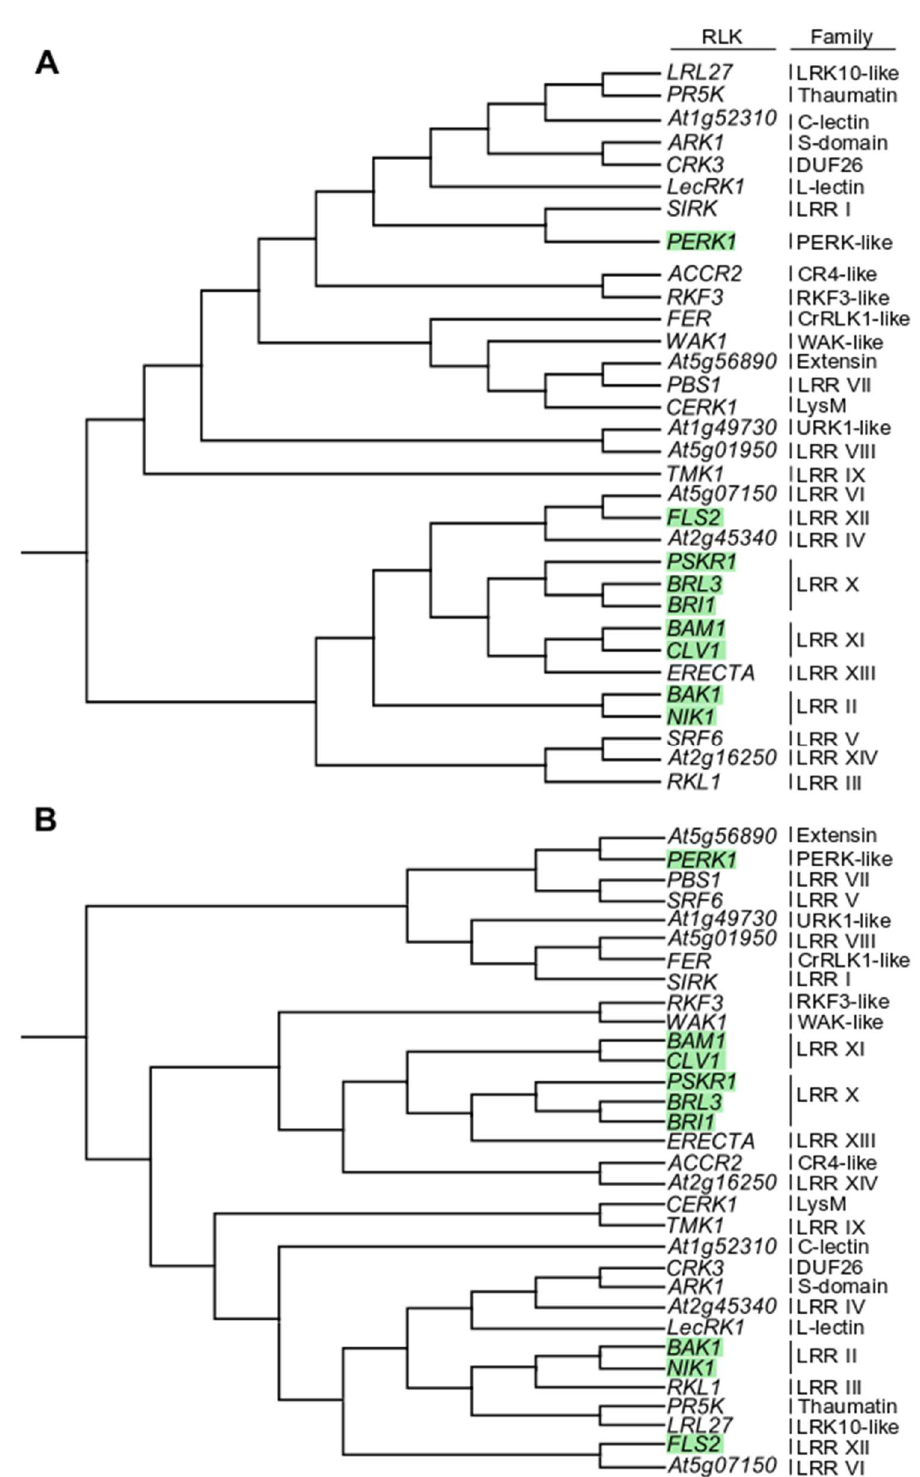
Figure 1. Phylogeny of representative members of the Arabidopsis receptor-like kinase (RLK) family. ( A ) Cladogram of representative Arabidopsis RLKs based on the full protein alignment. ( B ) Cladogram of representative Arabidopsis RLKs based exclusively on the intracellular domain. Green squares highlight RLKs used in this study. Families are indicated on the right. The phylogenetic analysis was performed using CLC Workbench 10.